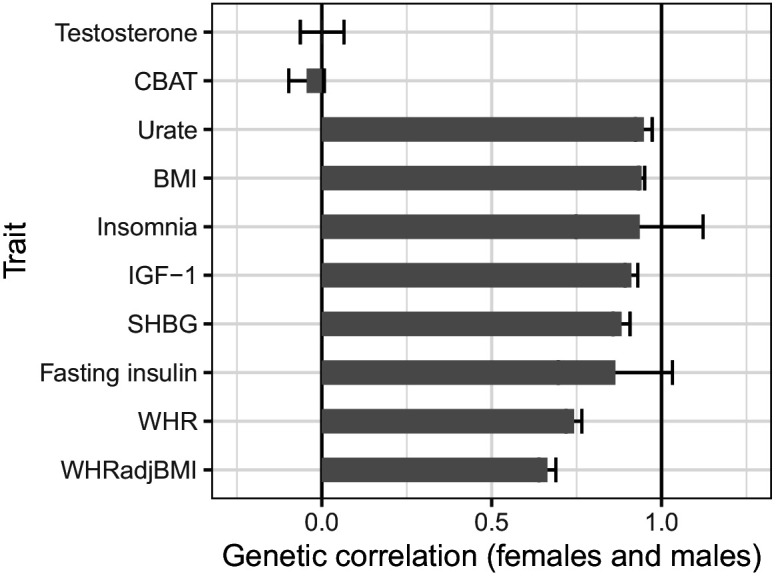
Genetic correlations between females and males across select traits.Both testosterone and calculated bioavailable testosterone (CBAT) show very little genetic correlation, in stark contrast to most other complex traits.